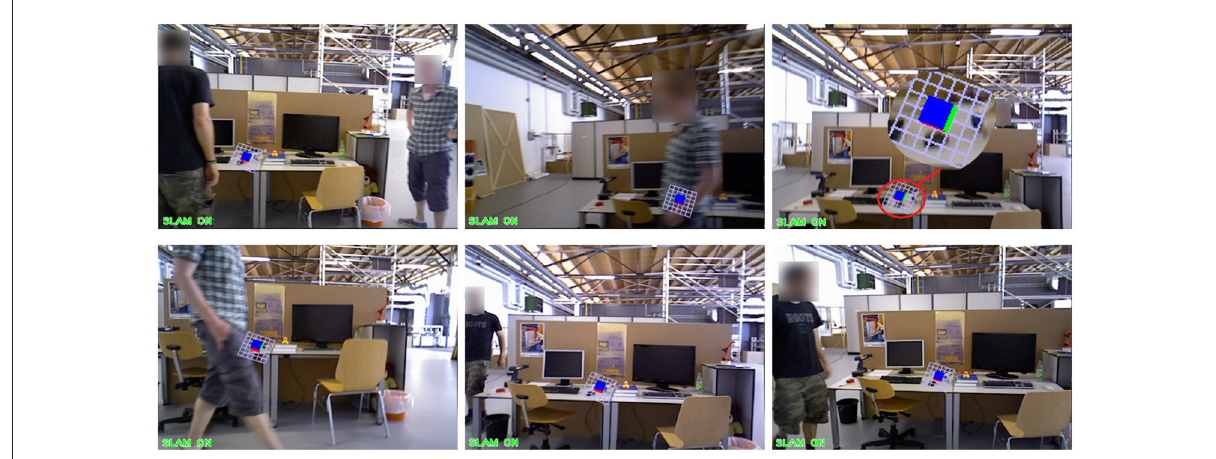
FIGURE15 The application effect of ORB-SLAM2 method in augmented reality experiment.